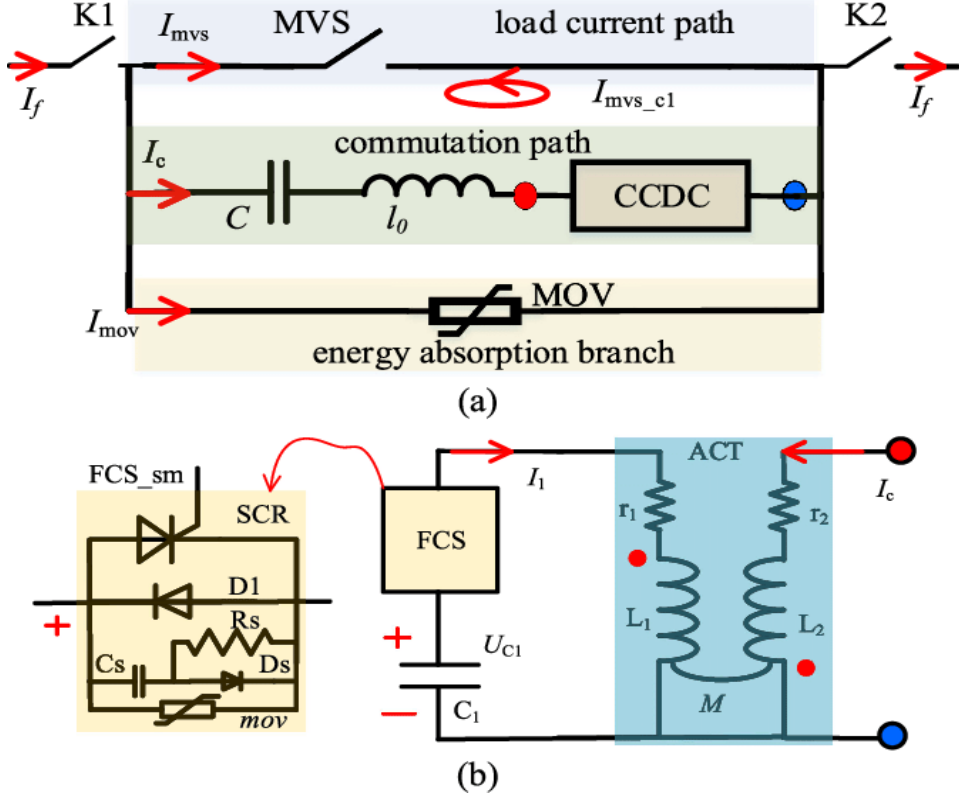
Figure 1. Topology of a conventional hybrid DCCB network. ( a ) Energy Absorption Branch; ( b ) FCS Branch.